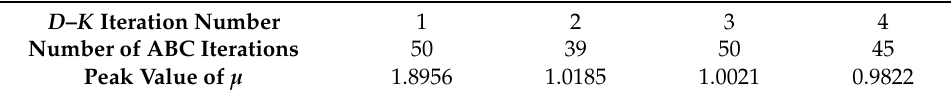
Table 2. The evolution of the structural singular value in the D – K iteration procedure used to solve the mixed-sensitivity fixed structure µ -synthesis problem for the case study—FO-PID